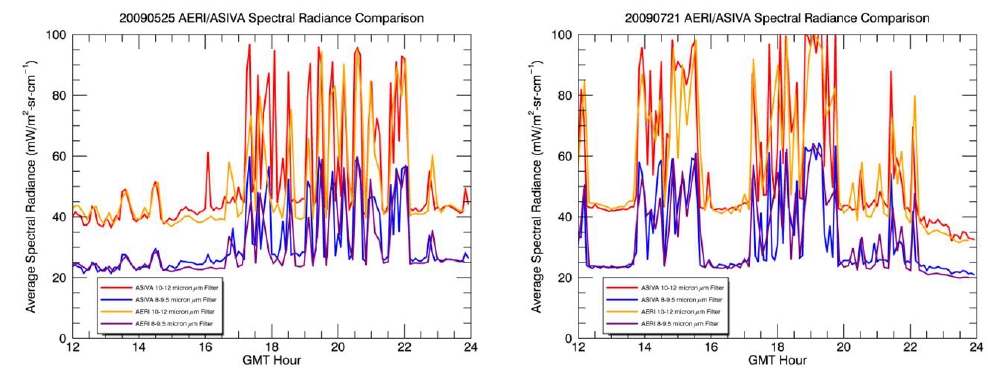
Fig. 5. Comparison of AERI with ASIVA spectral radiance data in each of the two filters for (a) 25 May 2009 and (b) 21 July 2009.